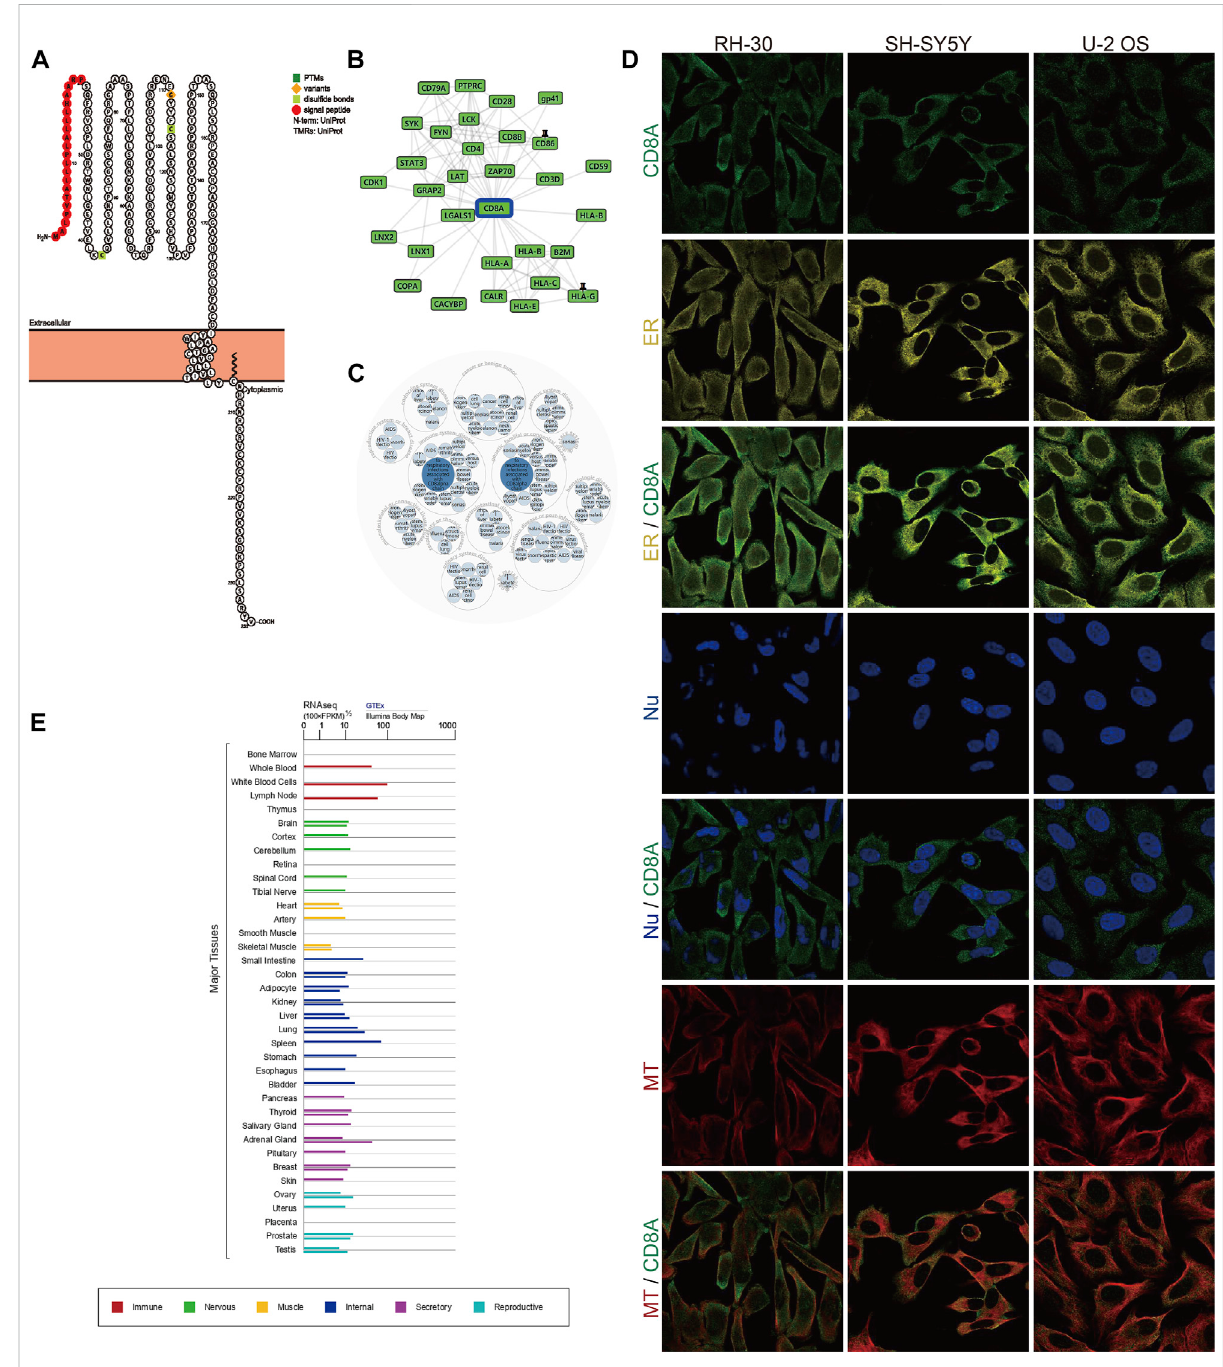
FIGURE 2 Protein topology, subcellular localization, PPI network analysis, and transcriptome expression of CD8A under normal physiological conditions (A) Protein topology of CD8A based on Protter database (B) PPI network construction of interacting genes with CD8A using GPS-Prot platform (C) Identi fi cation of diseases associated with CD8A via OPENTARGETS platform (D) Immuno fl uorescence analysisof cellular localization of CD8A inthe alveolar rhabdomyosarcoma RH-30, human neuroblastoma SH-SY5Y, and human osteosarcoma U-2 OS cell lines through HPA database (E) The transcriptome pro fi les of CD8A in varying systems and organs of human body from GTEx